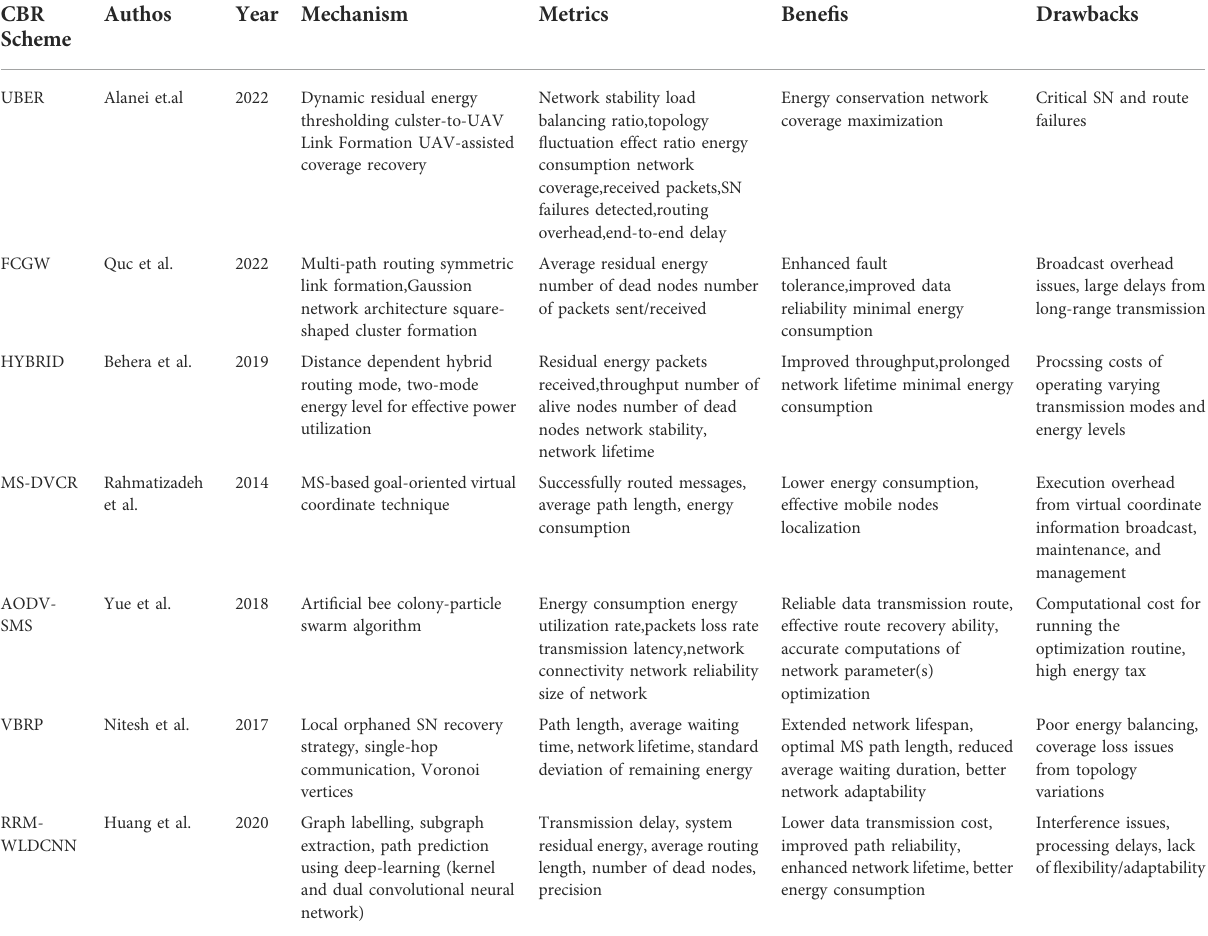
TABLE 1 Technical summary of reviewed CBR